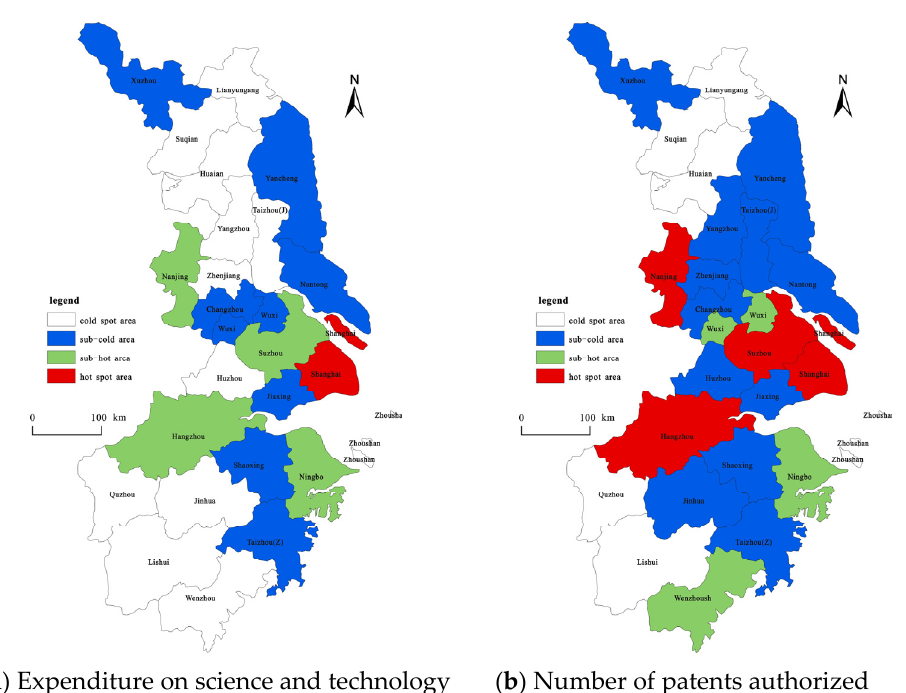
Figure 4. Spatial growth pattern of innovation inputs and outputs: 2004–2019.